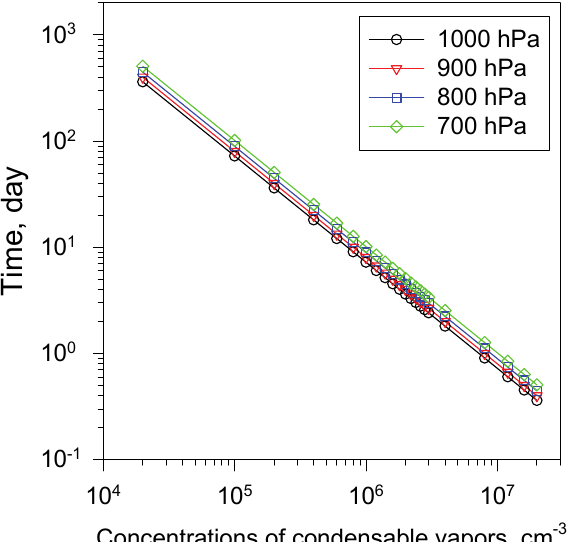
Fig. 7. Relationship between time to grow to D p > 10nm and con- centration of condensable vapours in the case of α =